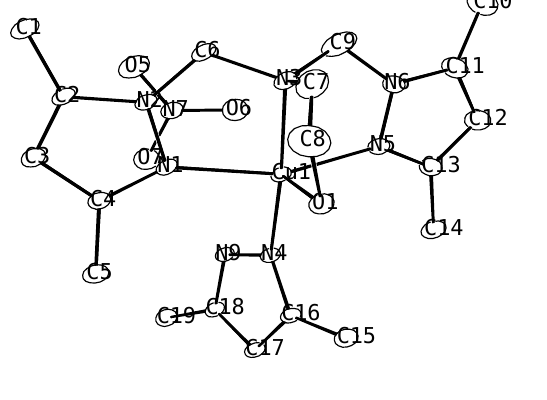
(NO ) . H atoms have been omitted for 0 3 2